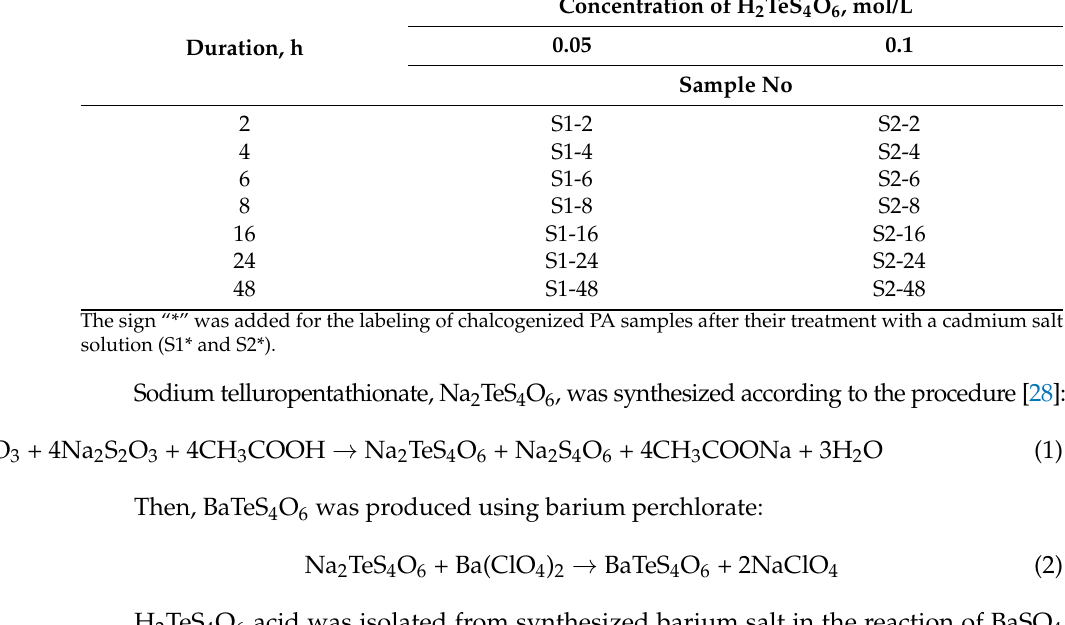
Duration, h Duration,